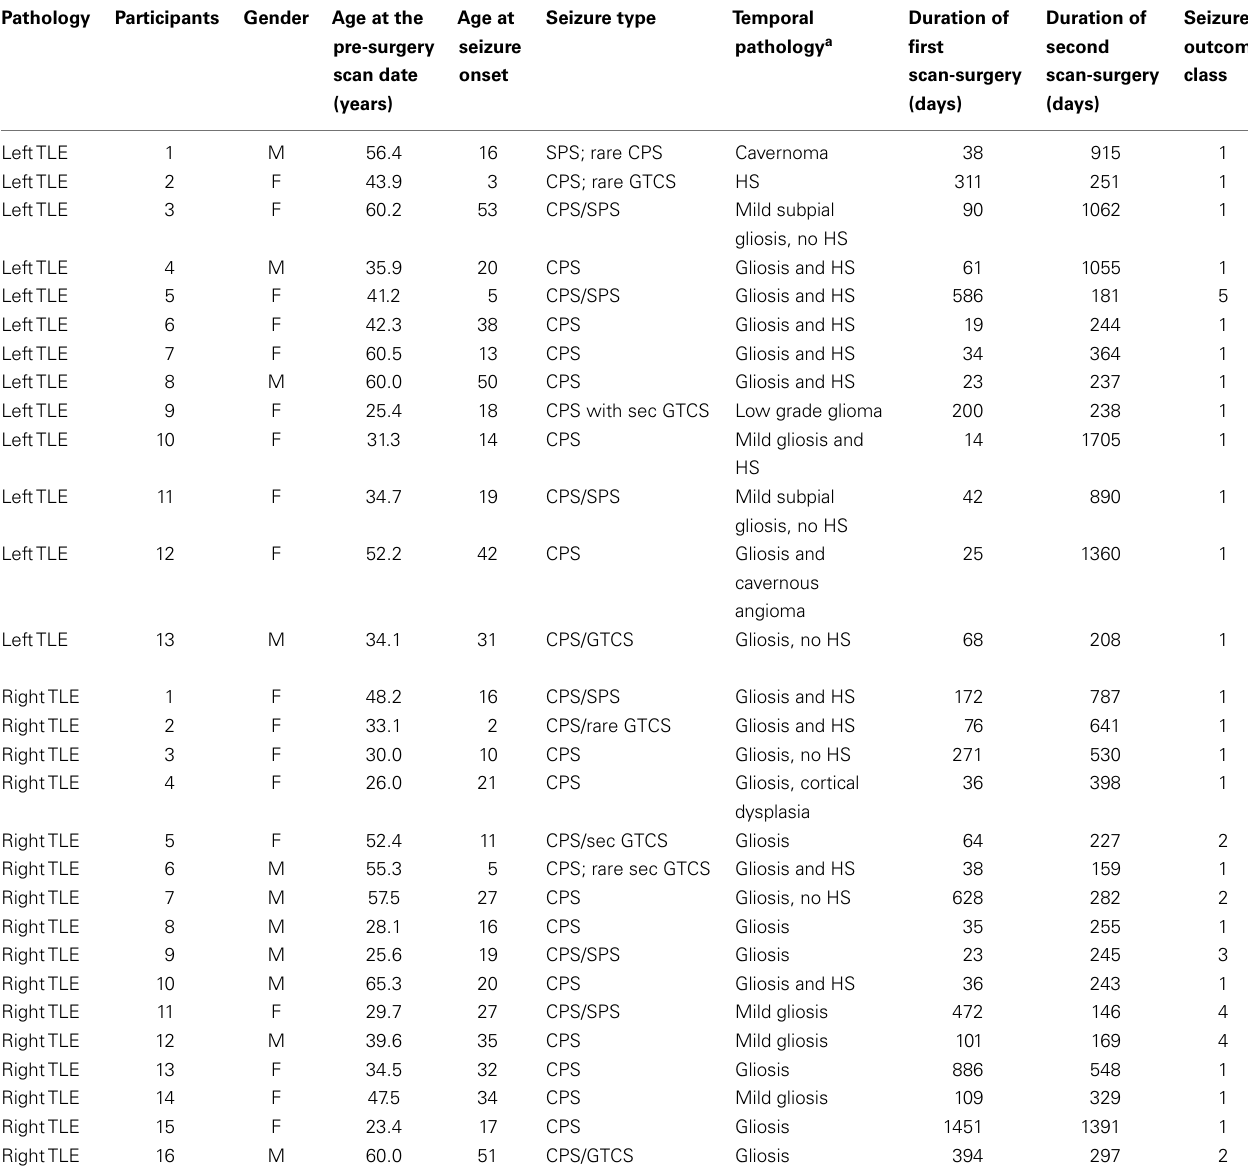
Table 1 | Clinical information and characteristics of the